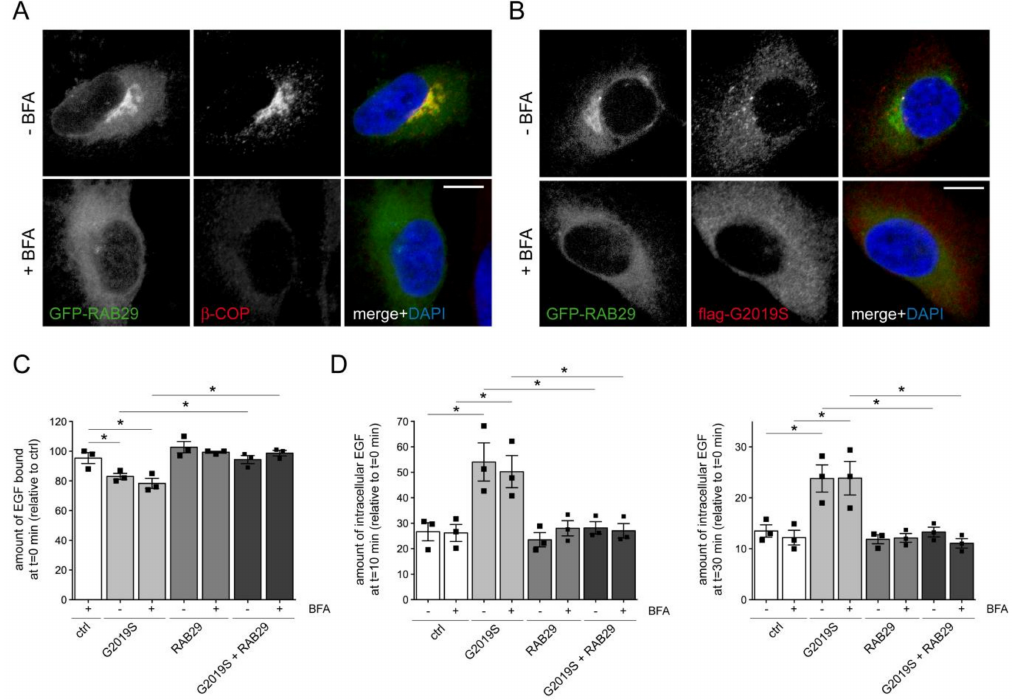
Figure 6. The G2019S LRRK2-mediated deficit in EGF tra ffi cking is rescued by RAB29 independent of Golgi integrity. ( A ) Example of HeLa cell transfected with GFP-RAB29 using Lipofectamine